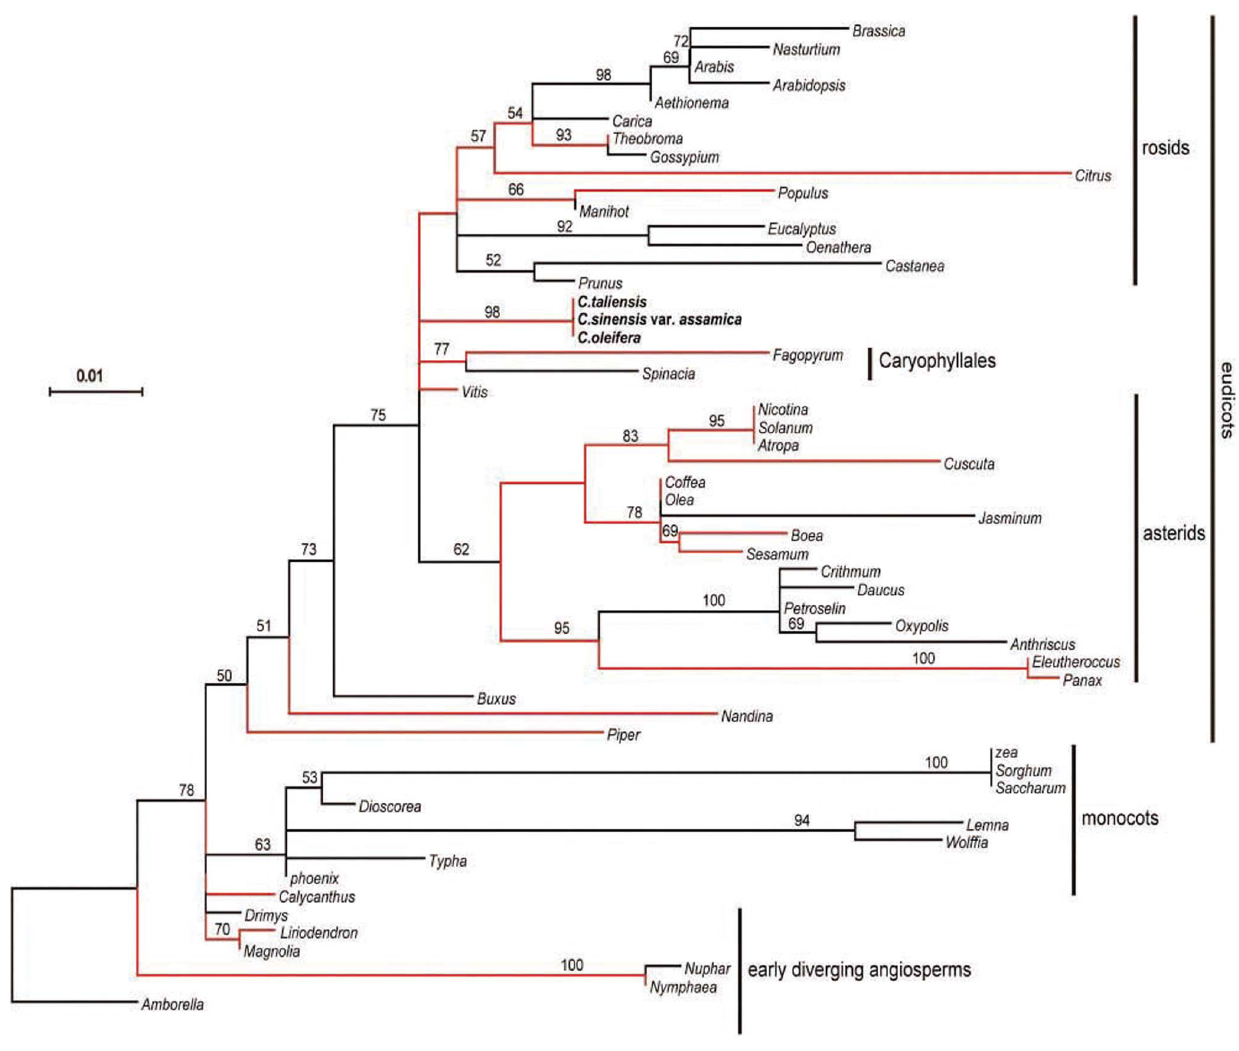
Figure 4. ML phylogram of 55 taxa based on ycf15 gene sequences. The analyzed genes include both intact and disabled sequences. The tree has a –lnL=1983.94. Bootstrap support values . 50% are given at nodes. The red branches indicate that intact ycf15 gene is present in related species. Scale bar indicates the increment of 0.01 substitutions per site.